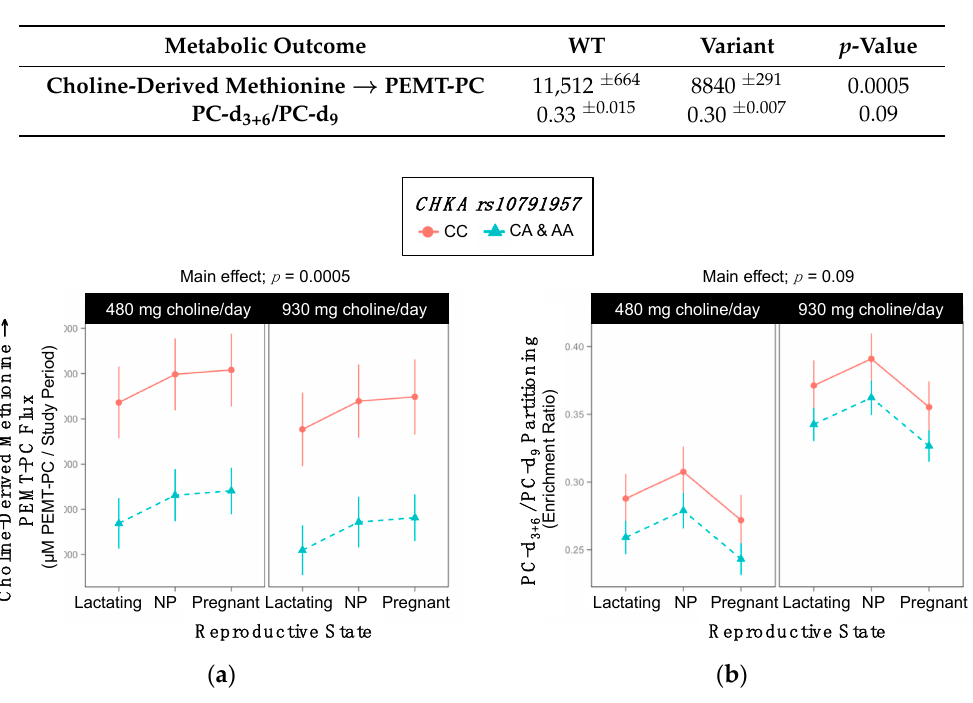
Table 3. CHKA rs10791957 genotype alters plasma choline metabolite partitioning and flux. Values